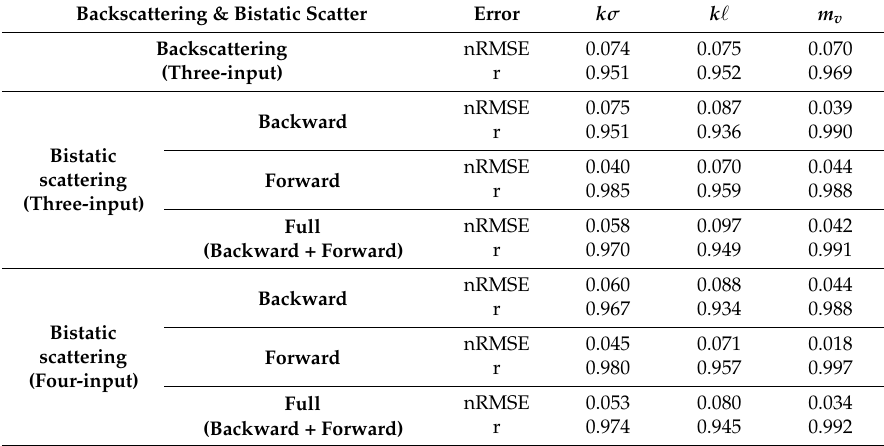
Table 5. DLNN inversion performance using backscattering and bistatic scattering.